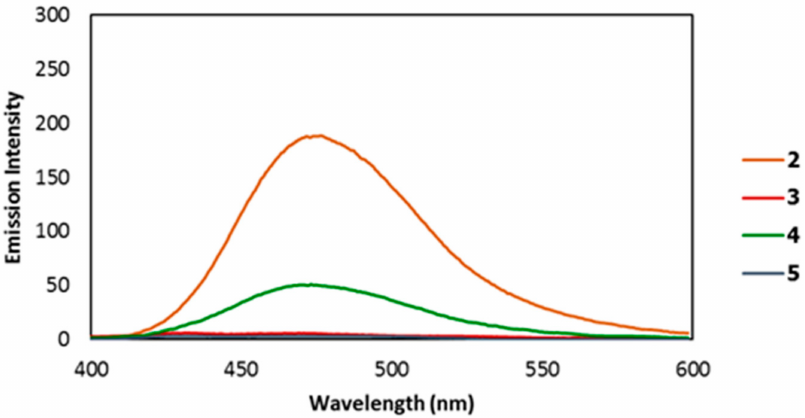
Figure 3. The fluorescence emission spectra of compound 2 , 3 , 4 , and 5 (2 µ M) obtained immediately after dissolving in HEPES buffer solution pH 7.4 (contain 0.8%